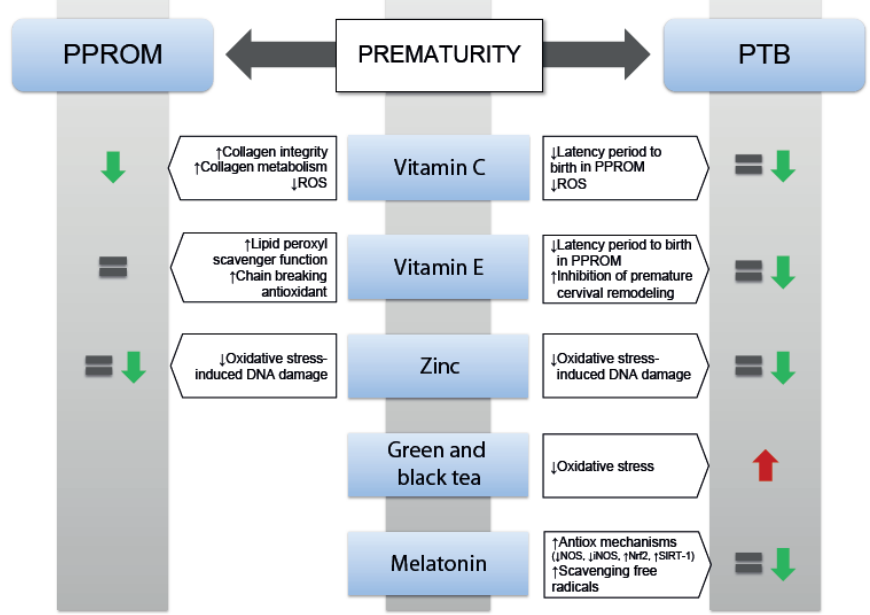
Figure 3. Main effects of the use of vitamin C, vitamin E, zinc, tea and melatonin in prematurity. Green arrow means reduction PPROM/PTB rates, red arrow means increase in PTB, and equal sign means no changes in PPROM/PTB rates. Abbreviations: iNOS: inducible nitric oxide synthase; NOS: nitric oxide synthase; Nrf2: NFE2-related factor-2; PPROM: preterm premature rupture of membranes; ROS: reactive oxygen species; SIRT-1: sirtuin-1; ↓ : decrease; ↑ : increase.